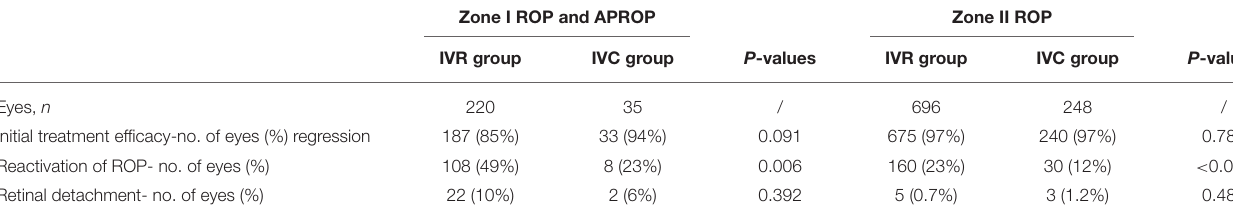
TABLE 3 | The comparison of efficacies and treatment outcomes of IVR and IVC.